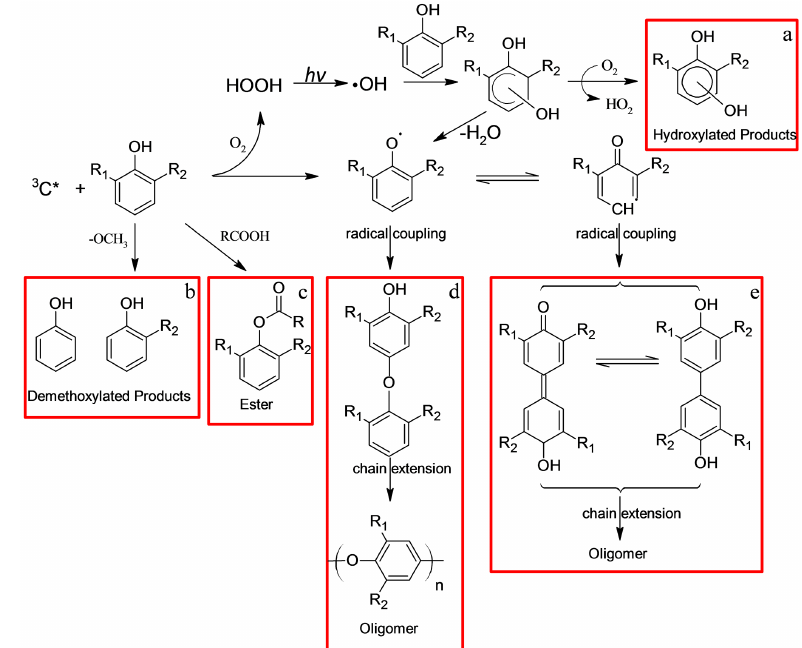
Figure 7. A schematic illustrates the formation of hydroxylated species, dimers and higher oligomers, esters, and demethoxylated products from aqueous photooxidation of phenolic compounds. Species produced via pathways a–e may undergo further ring-opening processes to form ketones and carboxylic acids. Phenol: R 1 = H, R 2 = H; Guaiacol: R 1 = OCH 3 , R 2 = H; Syringol: R 1 = OCH 3 , R 2 = OCH 3 . Note that while radical coupling here is shown through the carbon opposite (para) the phenoxy group, other geometric isomers will also be formed during these